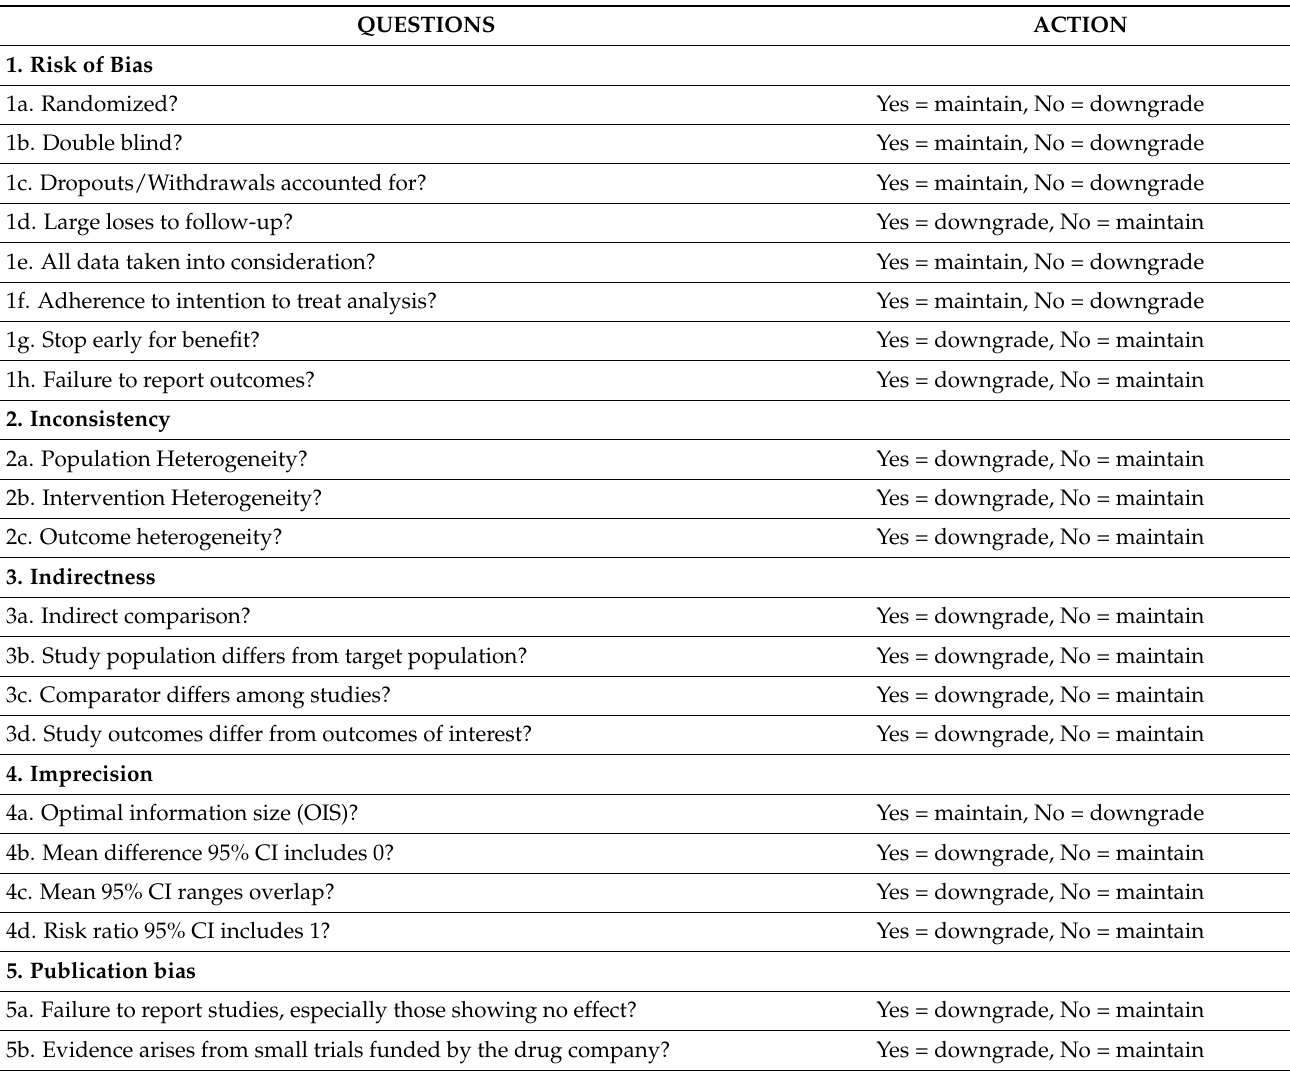
Table 1. Critical questions to evaluate the clinical evidence of each study, based on GRADE